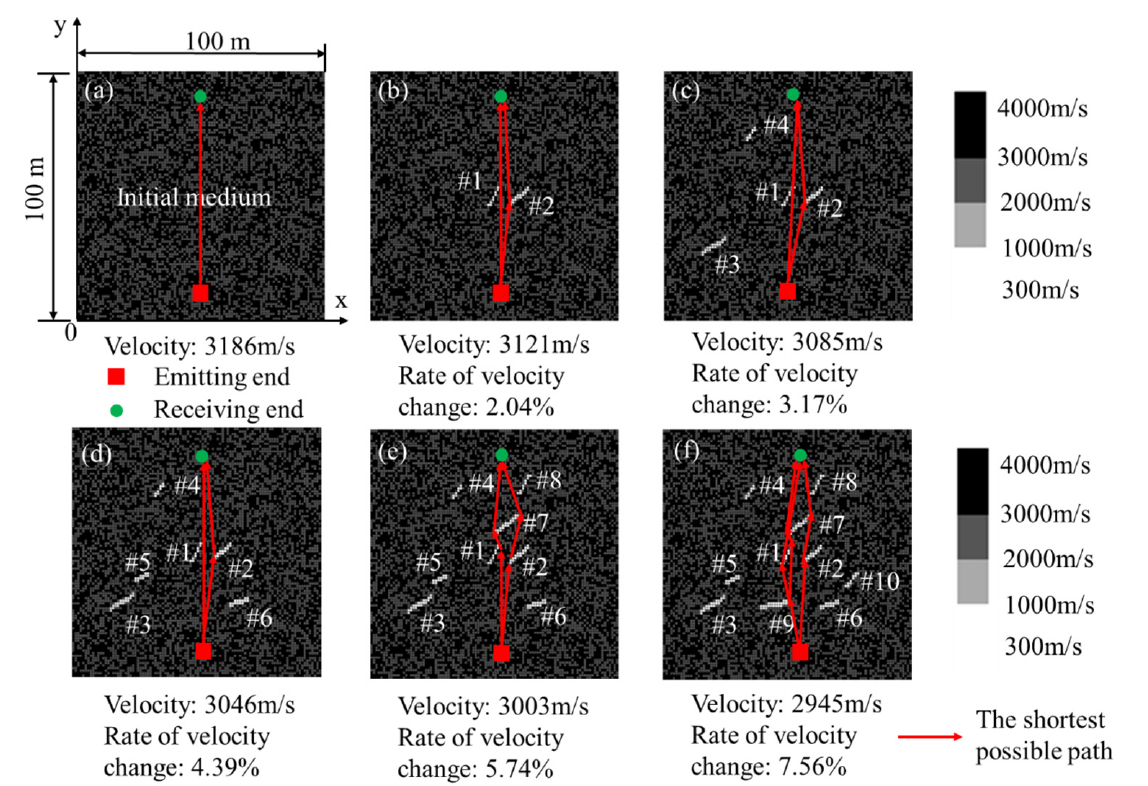
Figure 7. ( a ) The initial medium with no crack; ( b – f ) The medium with 2, 4, 6, 8, and 10 cracks.